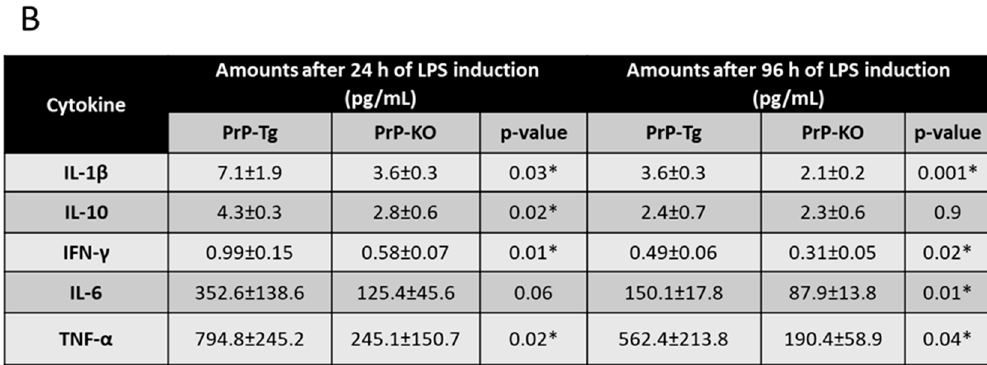
Figure 3. ( A ) LPS treatment increased PrP C expression in primary murine microglial cells. Primary microglial cells were isolated from PrP-KO mice with an almost pure FVB genotype (strain F10),